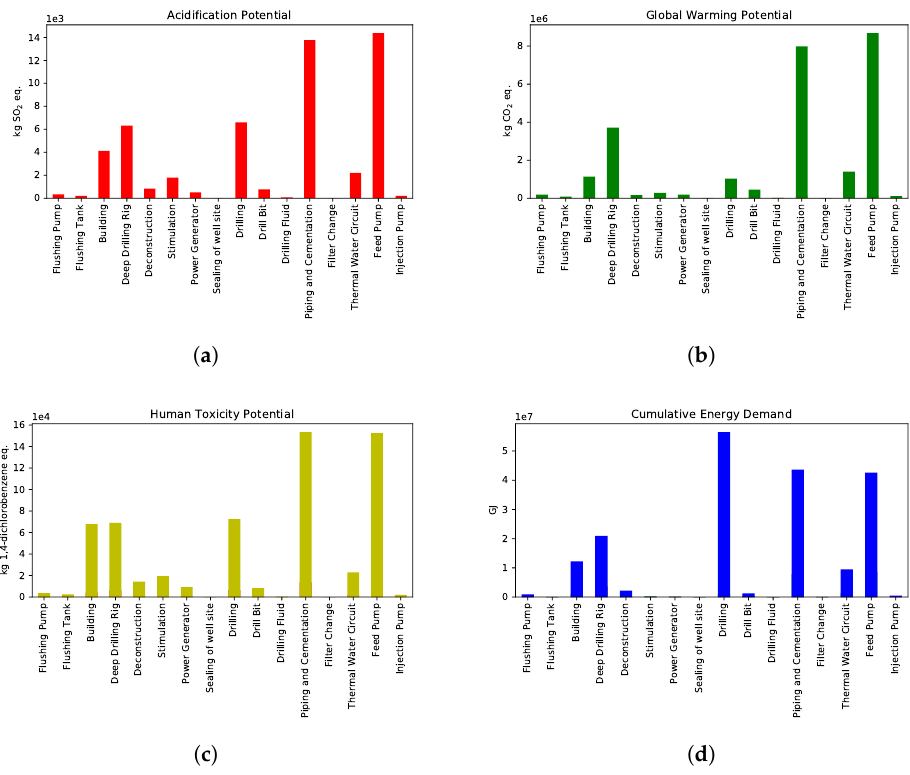
Figure 4. LCA results of a geothermal station for: ( a ) AP; ( b ) GWP; ( c ) HTP and ( d ) CED.